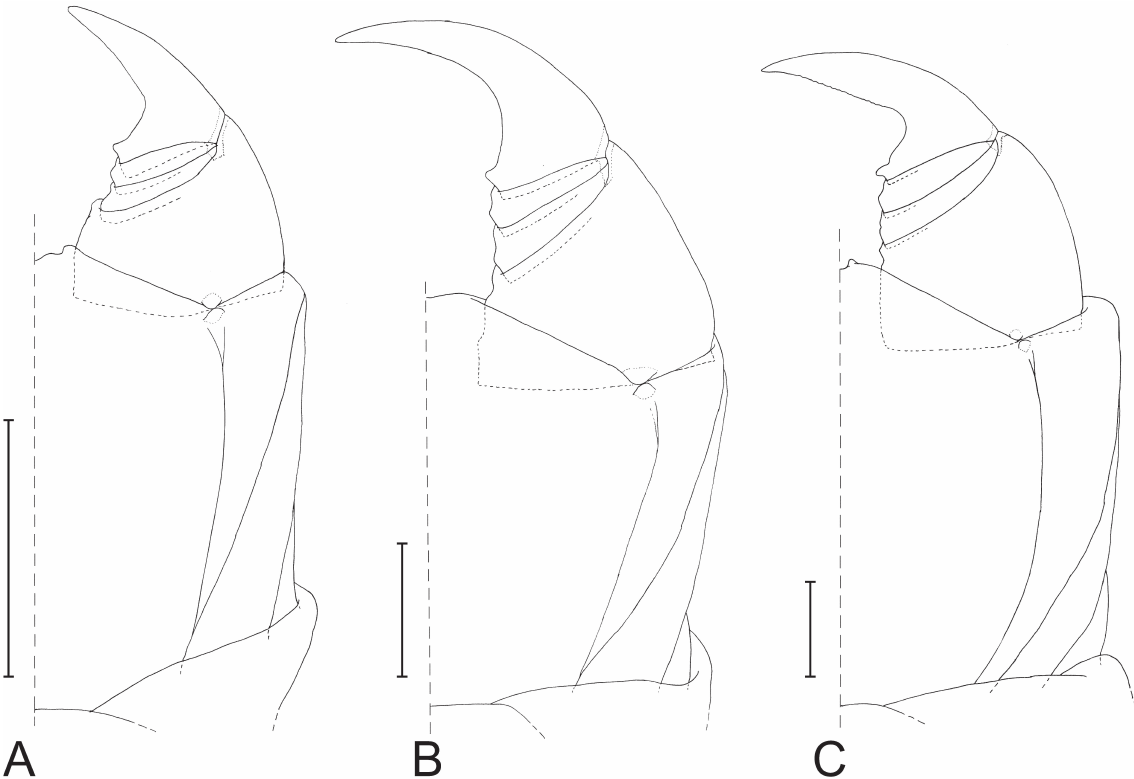
Fig. 4. Forcipules of Endogeophilus ichnusae gen. et sp. nov. and the two most similar geophilid species. Left part of the forcipular segment, ventral view, in adult females. A . E. ichnusae gen. et sp. nov., holotype, ♀, original drawing. B . Geophilus electricus (Linnaeus, 1758), original drawing from a representative specimen, ♀ (see ‘Material and methods’). C . Galliophilus beatensis Ribaut & Brolemann, 1927, holotype, ♀, redrawn from Brolemann (1927). Scale bars = 200